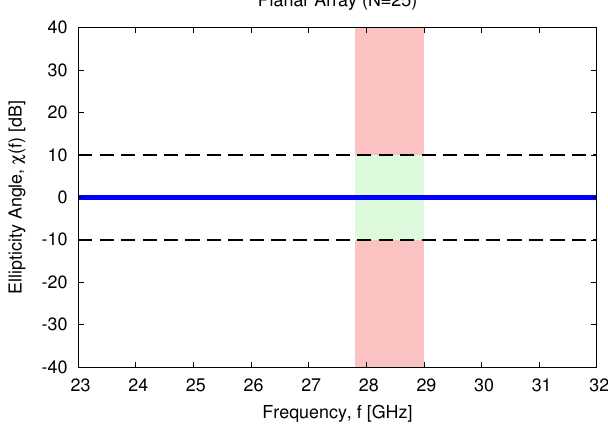
(cid:105) (cid:104) ( p ) ( p ) = [ 27.8, 29.0 ] (GHz))—Plot of the ellipticity f , f max min